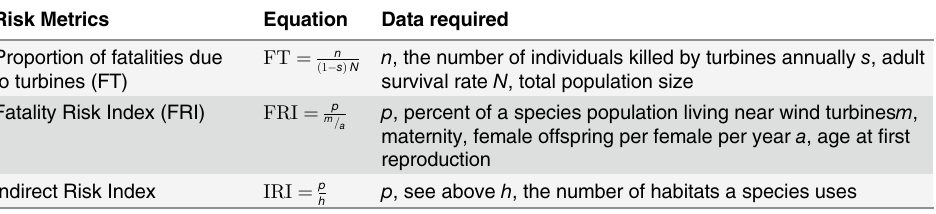
Table 1. The risk metrics used in the prioritization, their equations, and data required. Risk